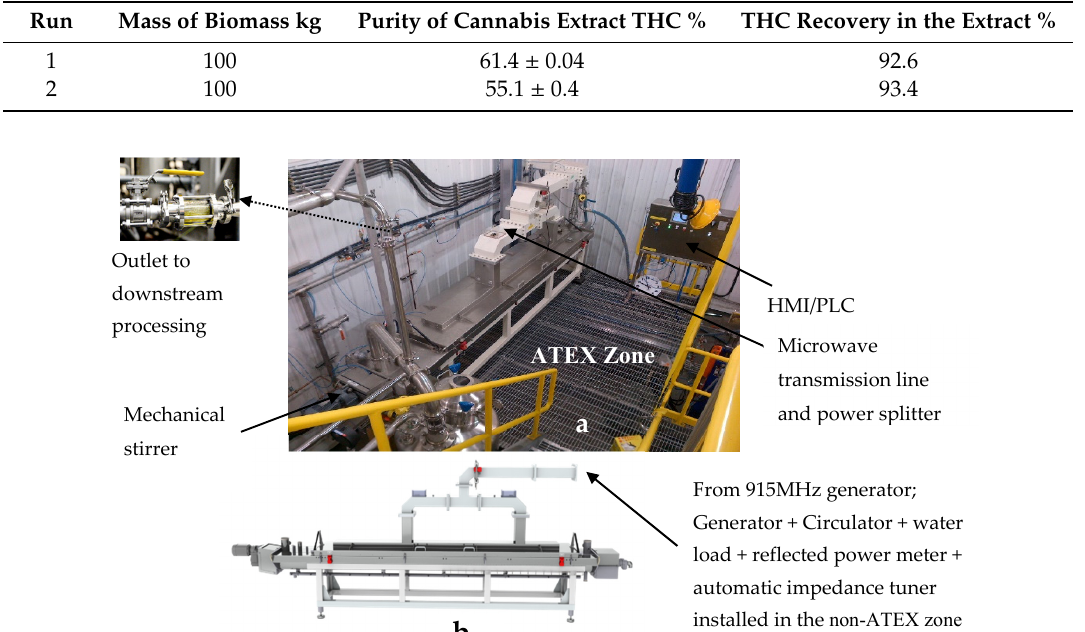
Table 2. Results of industrial scale cannabinoid extraction runs from cannabis biomass; biomass flow 30 kg / h, solvent (ethanol) flow 360 L / h.